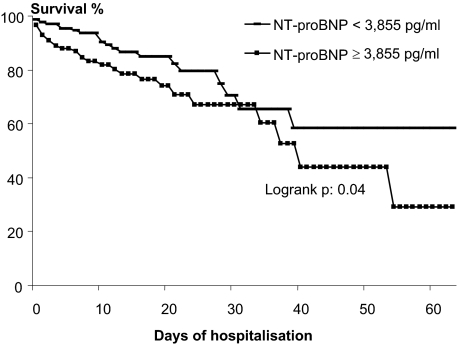
Kaplan-Meier curves showing survival according to NT-proBNP (from Chenevier-Gobeaux with permission (Chenevier-Gobeaux et al. 2007)).